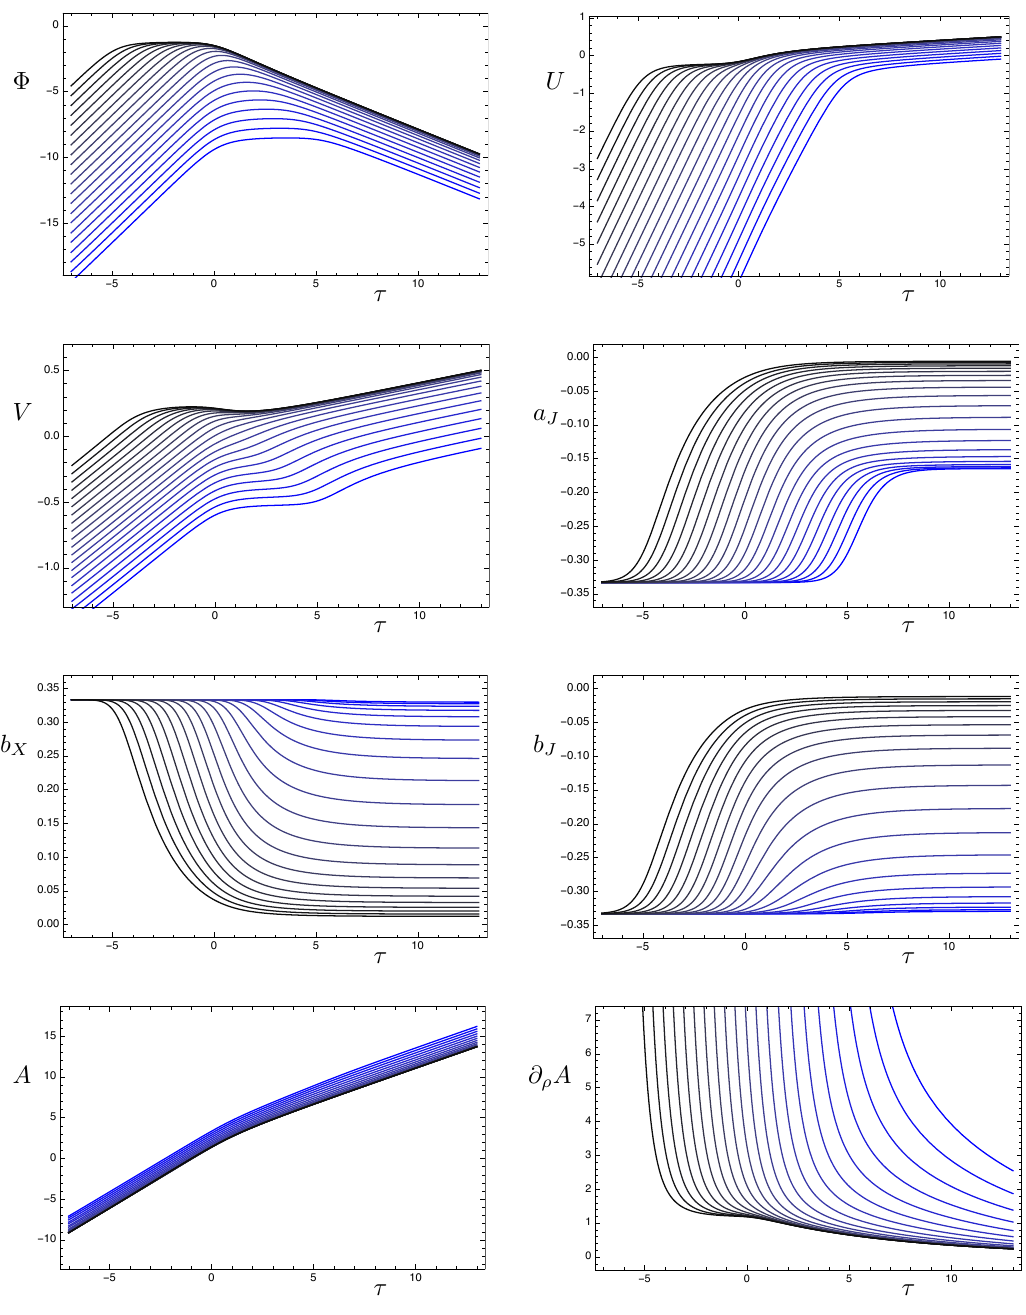
Figure 3 . Background functions for (cid:28) to black (blue). We have put Q c = 1 = 3, Q k = (cid:0) 1, q c = 0 (the reason for this choice is explained in section